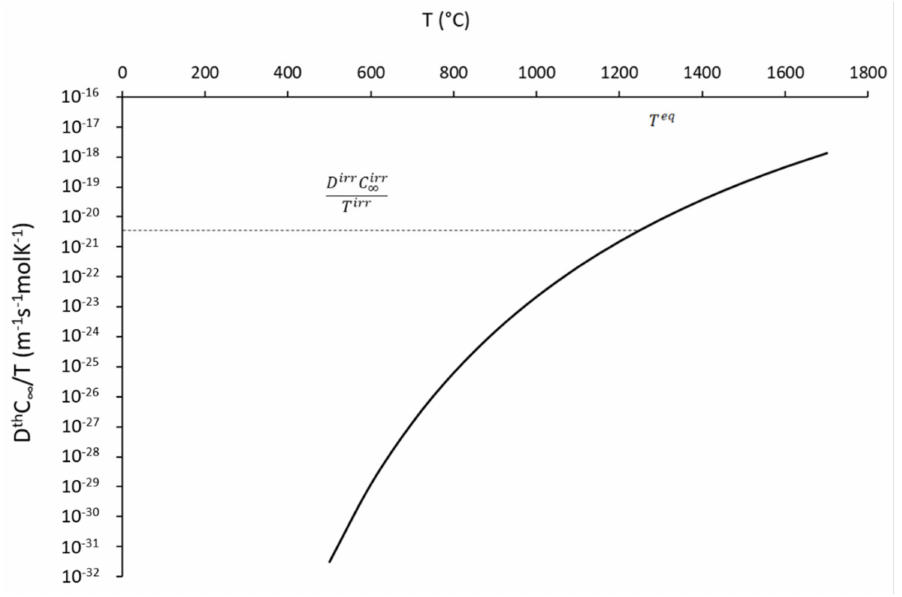
Figure 15. Evolution of D th C ∞ against temperature, used in order to determine the equivalent temperature. T